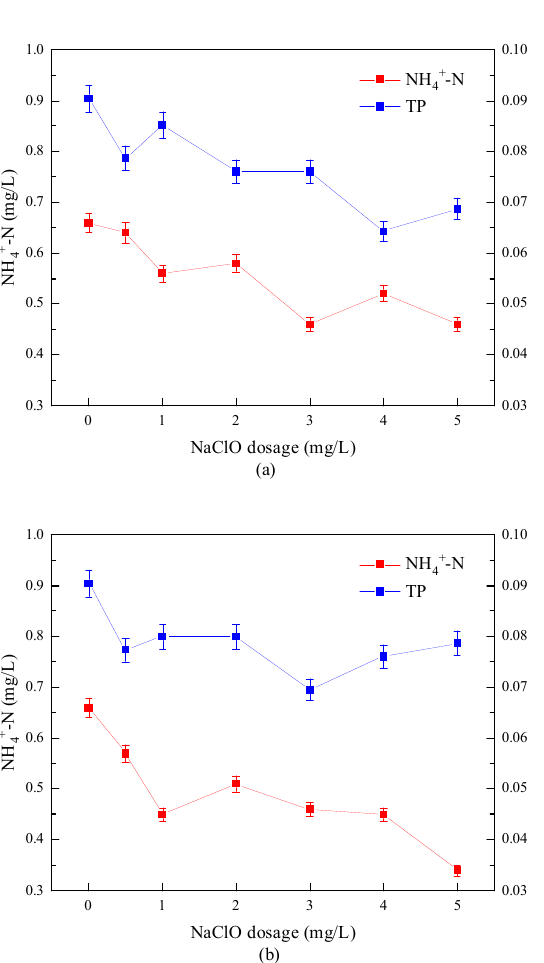
Figure 7. Removal effect of combined disinfection on NH 4+ -N and TP. ( a ) “Method A”; ( b ) “Method